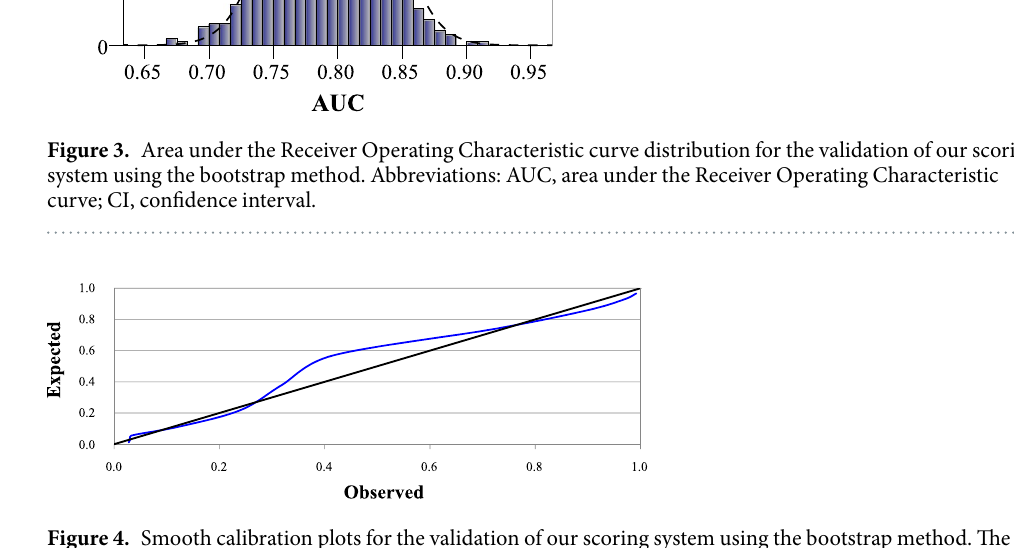
Figure 4. Smooth calibration plots for the validation of our scoring system using the bootstrap method. The black line represents perfect calibration and the grey line indicates the results of our calibration. The error (observed-expected in %) in each score was (ordered from 0 to 10 points; in parentheses we indicate the proportion of patients with each score): 1.53 (7.7%), 0.34 (5.9%), − 2.30 (18.9%), 1.08 (17.6%), 2.11 (14.0%), − 6.05 (12.6%), − 15.36 (10.8%), − 1.53 (5.0%), 4.04 (5.4%), 3.95 (1.8%) and 2.48%